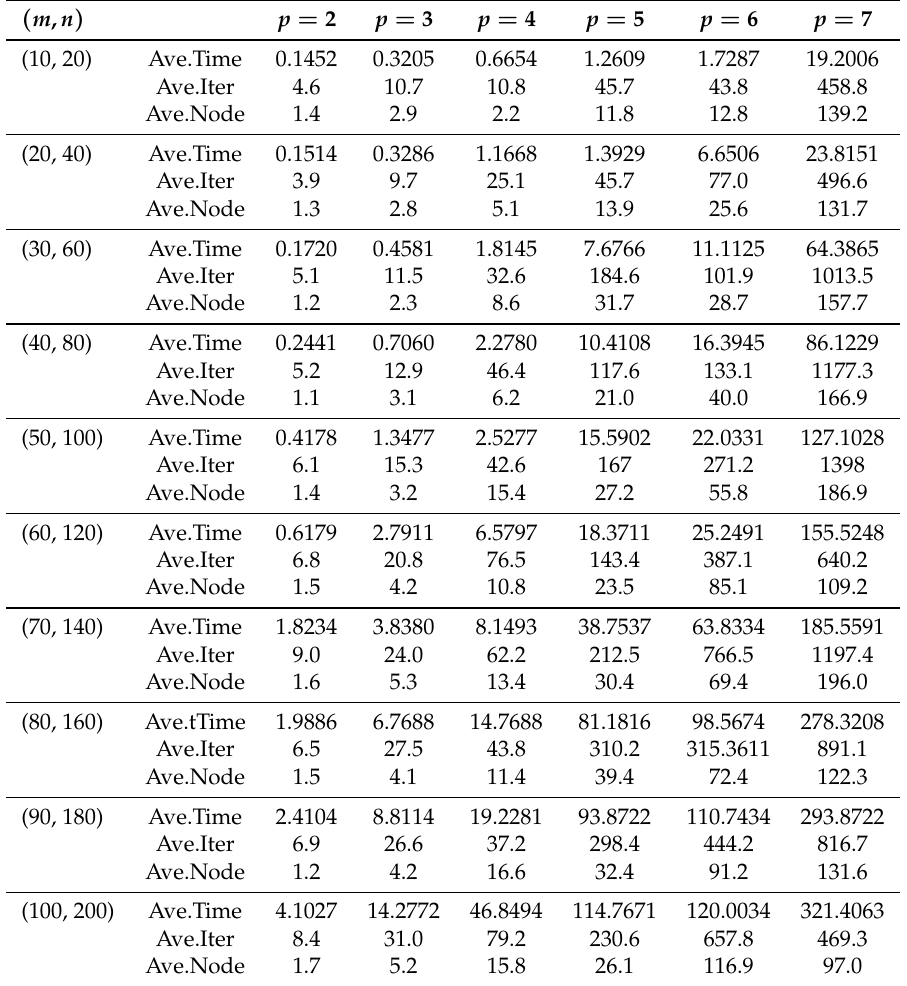
Table 4. The results of random calculation for